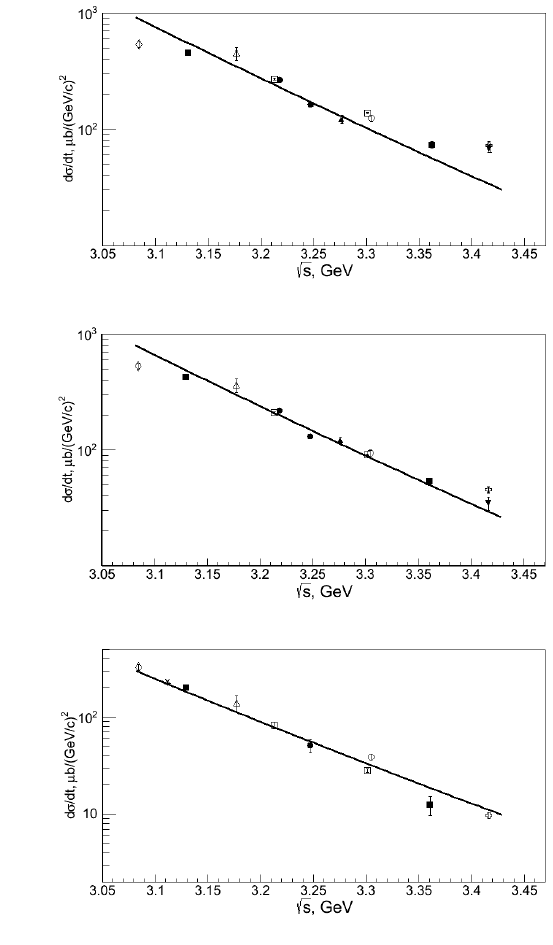
Figure 7. Di ff erential cross section of dp -elastic scattering at fixed